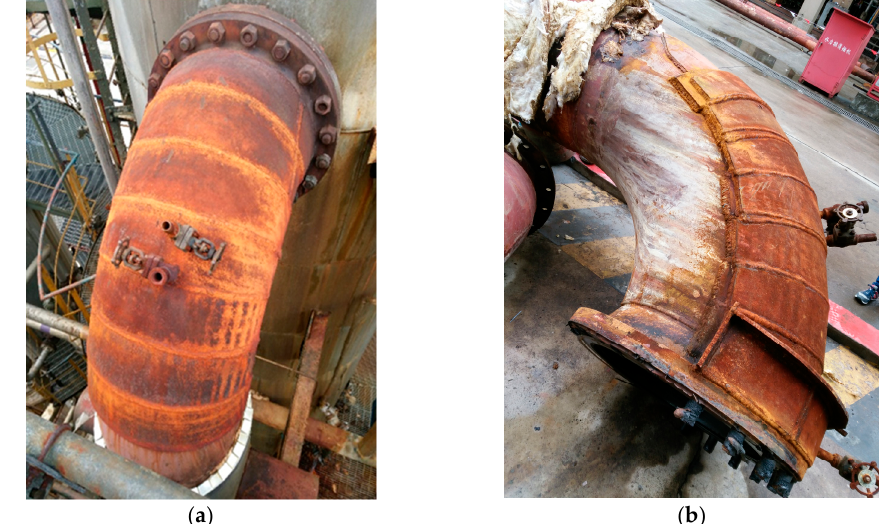
Figure 2. The elbow before and after repair: ( a ) elbow; ( b ) elbow with additional plates.